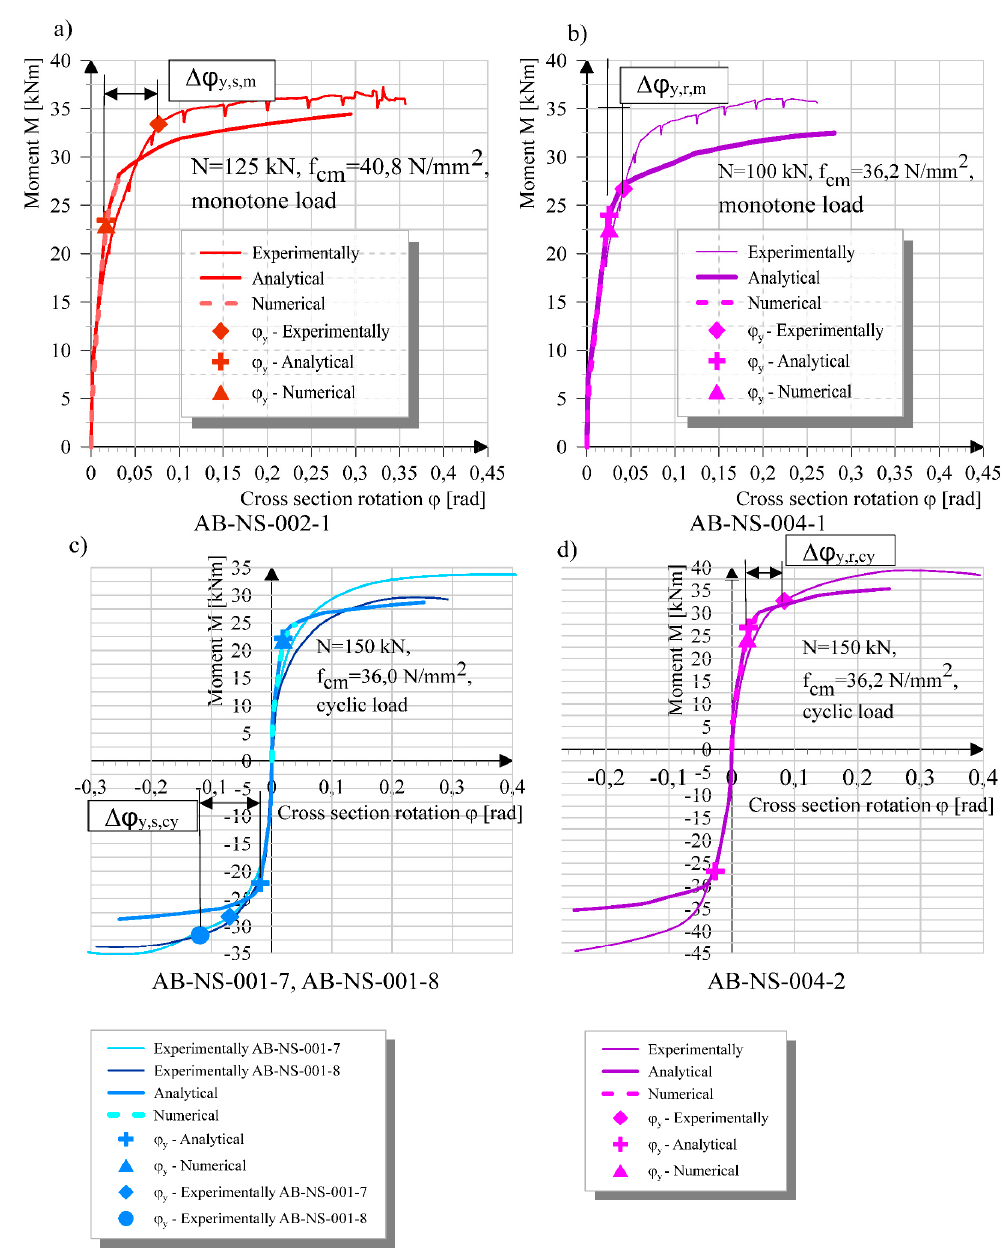
Figure 14. Moment to section rotation ratios: ( a ) monotonous specimen with smooth reinforcement; ( b ) monotonous specimen with ribbed reinforcement; ( c ) cyclical specimens with smooth reinforcement; ( d ) cyclical specimen with ribbed reinforcement.